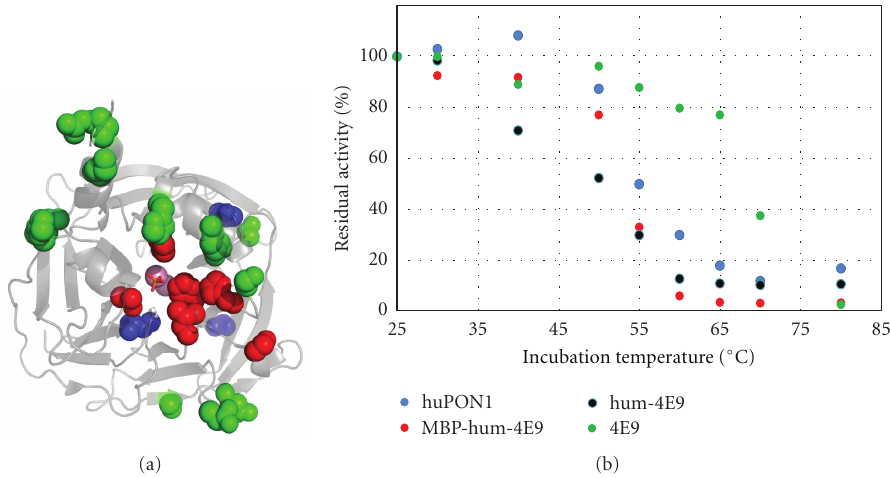
Figure 8: Humanization of 4E9. (a) The g2e6p mutations are shown in green spheres; the three additional mutations M55L, A126T, and V206T, are shown in blue spheres; the 4E9 mutations (with respect to G3C9) are shown in red spheres. (b) Thermal inactivation of hum-4E9 produced with and without MBP fusion is compared to huPON1 and 4E9. Residual activity here was from EMP hydrolysis rather than phenyl acetate because the H115W mutation renders PON1 inactive against phenyl